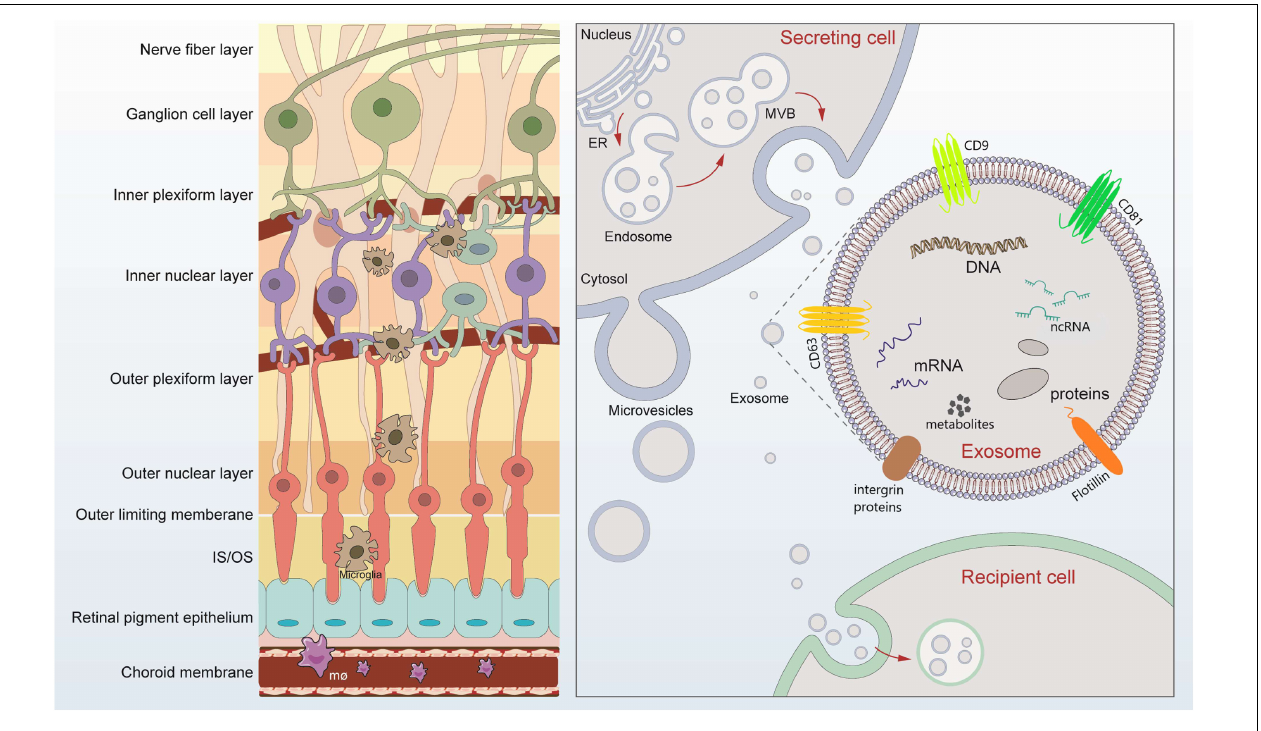
FIGURE 1 | Retinal layers and schematic signaling transferred by exosomes. Retina can be roughly divided into nine layers, which tightly contact lay by lay. Exosomes are released after fusion of multivesicular bodies (MVBs) with the plasma membrane. The lipid bilayer of exosomes contains specific lipids such as cholesterol and phosphatidylserine, which protect the contents from degeneration. The cargos loaded by exosomes includes microRNAs, long-non-coding RNAs, DNA, message RNA, lipids, metabolites, and proteins, mediating possible exchange among different retinal cells. Exosomes of different cellular origin share certain common protein components such as CD9, CD81, and